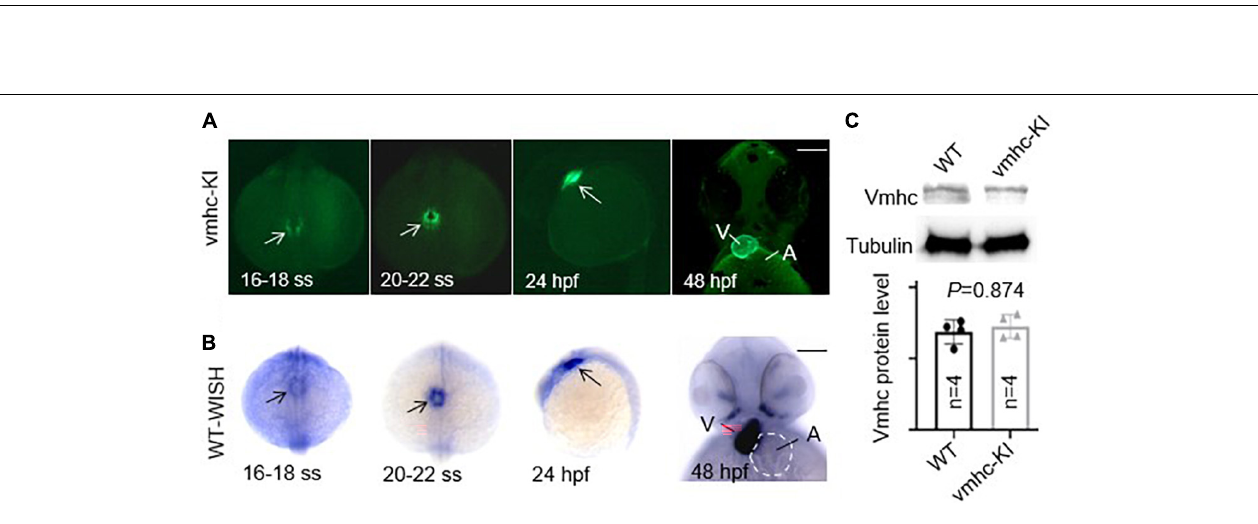
Frontiers in Cardiovascular Medicine |